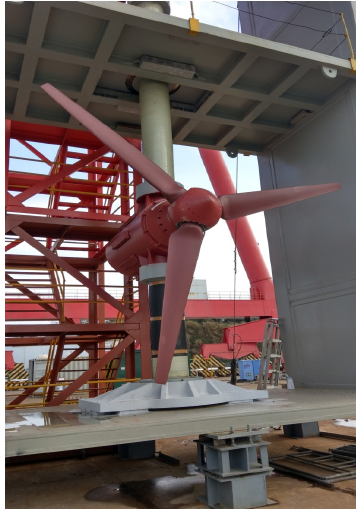
Figure 31. F-module by LHD and Blue Shark Power System, 300 kW. Reproduced from [82].